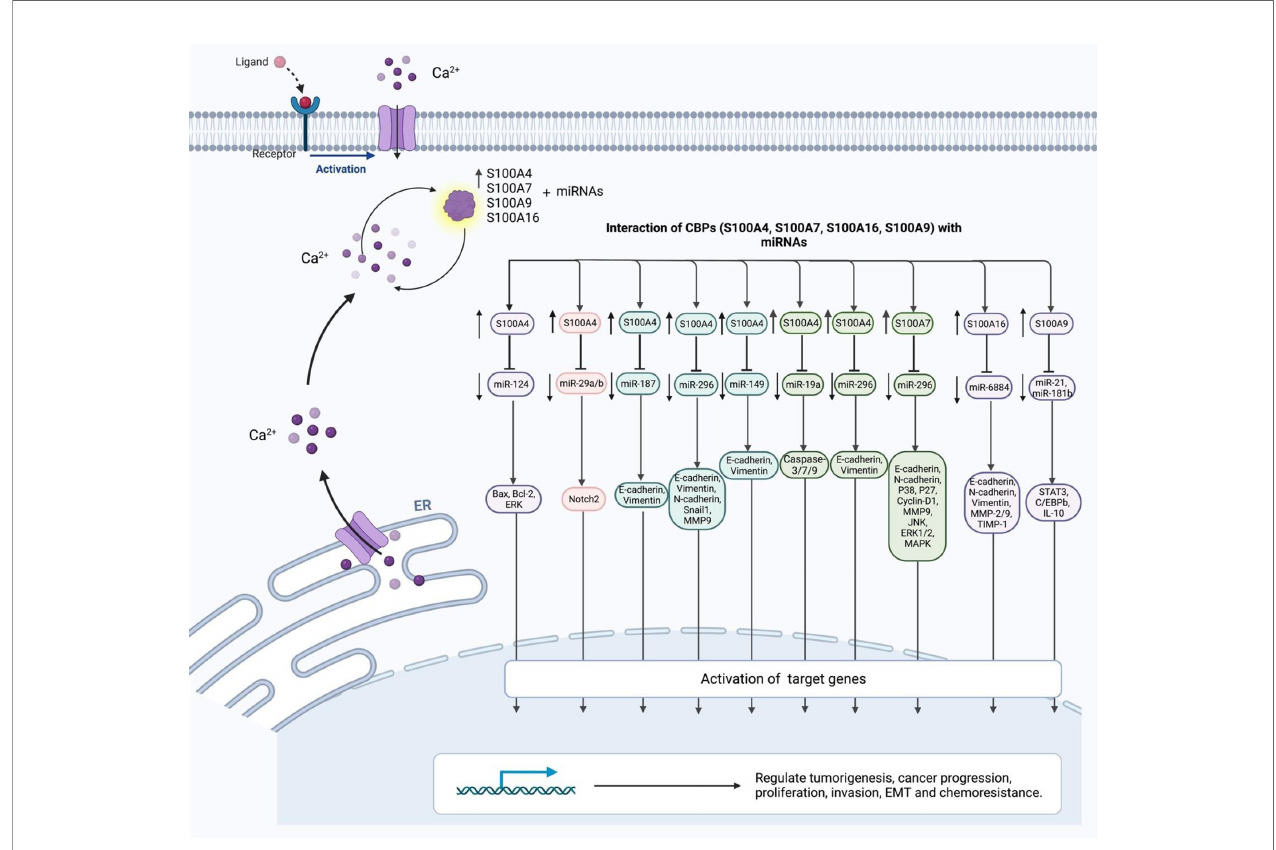
FIGURE 3 | The interaction of CBPs (S100A4, S100A7, S100A16, S100A9) with